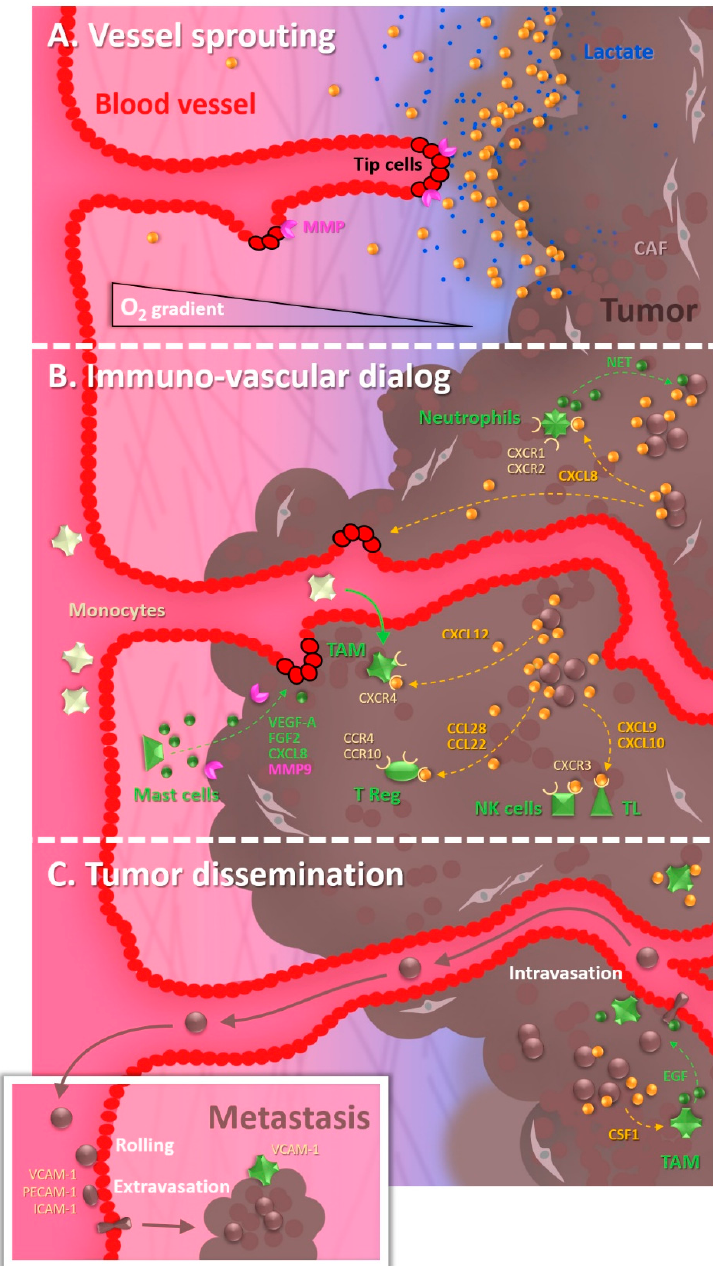
Figure 1. The tumor microenvironment octopus. ( A ) Tumors secrete a wide array of pro-angiogenic molecules. Hypoxia is a primary driver of angiogenesis, promoting these molecules’ expression. Moreover, lactate production by hypoxia-associated glycolysis also stimulates the invasion of endothelial tip cells. ( B ) Immune cells are recruited via the chemokines secreted by tumor cells. Although initially aimed at inhibiting tumor growth, immune cells also display several pro-tumorigenic actions. Mast cells, M2-like macrophages, and T-reg lymphocytes stimulate angiogenesis. These last two cell types also generate an immunosuppressive environment. Moreover, Neutrophil Extracellular Traps (NETs) can wrap tumor cells and form a protective shield around them. ( C ) The metastatic cascade initiates with the intravasation of tumor cells, which is promoted by the presence of macrophages. Circulating tumor cells then extravasate and colonize a distant site, in which macrophages can again help them by favoring their